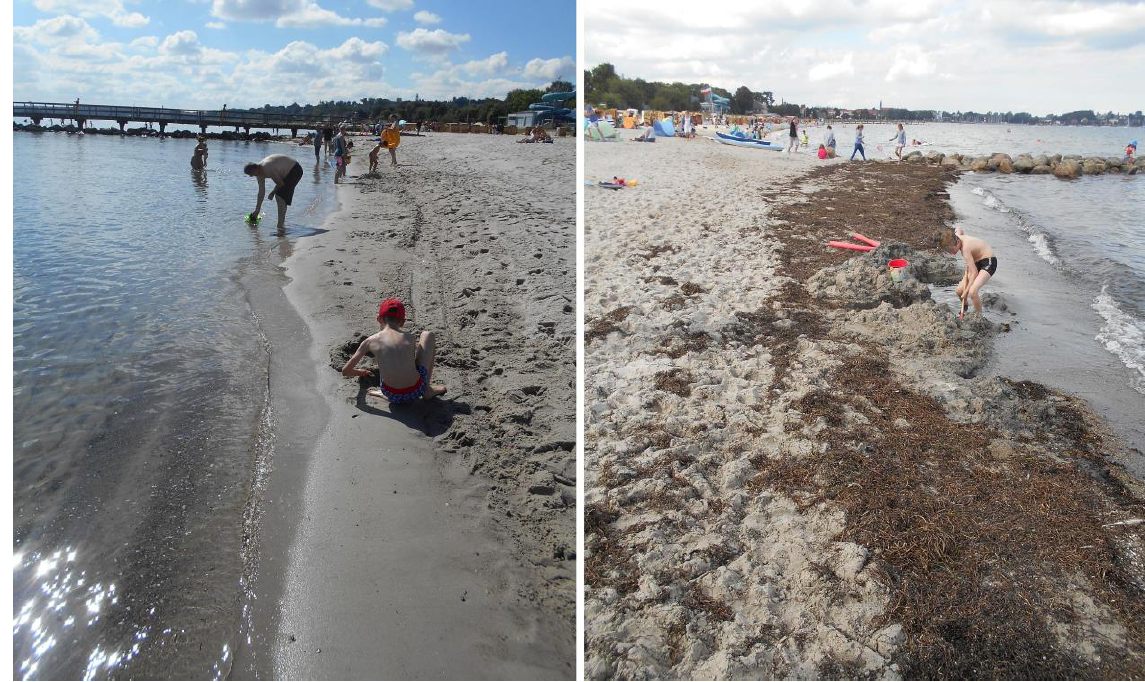
Figure S3: Minimal (0 g m -1 ) and maximal (15600 g m -1 ) densities of beach wrack tested for effects on beach visitors in experiment